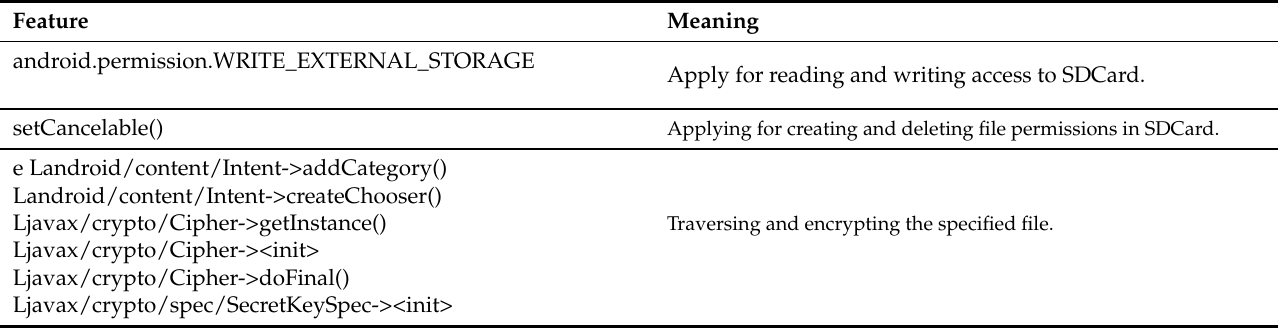
Table 2. Typical features of files encryption ransomware